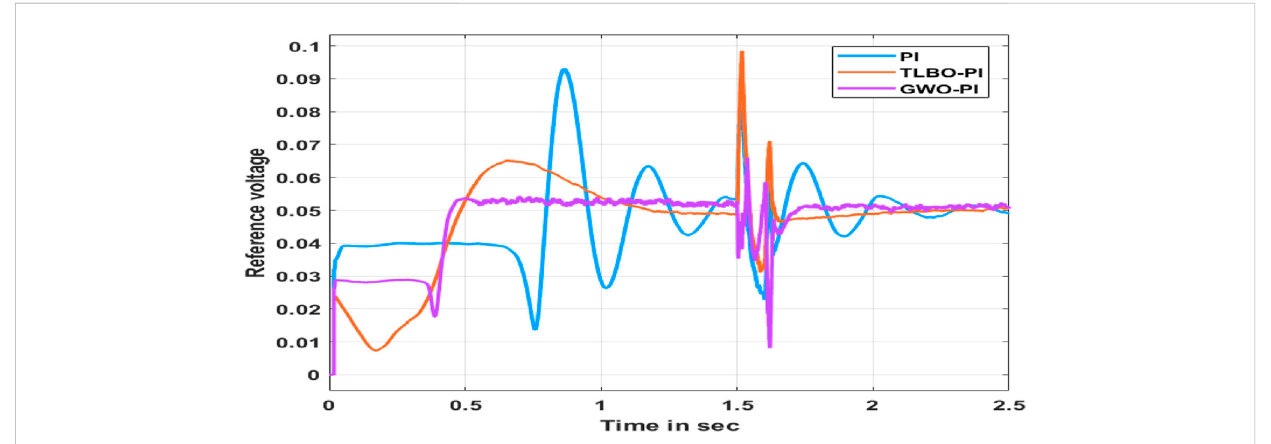
FIGURE 10 Comparison of the measured voltage amplitude of the SSSC injected voltage.